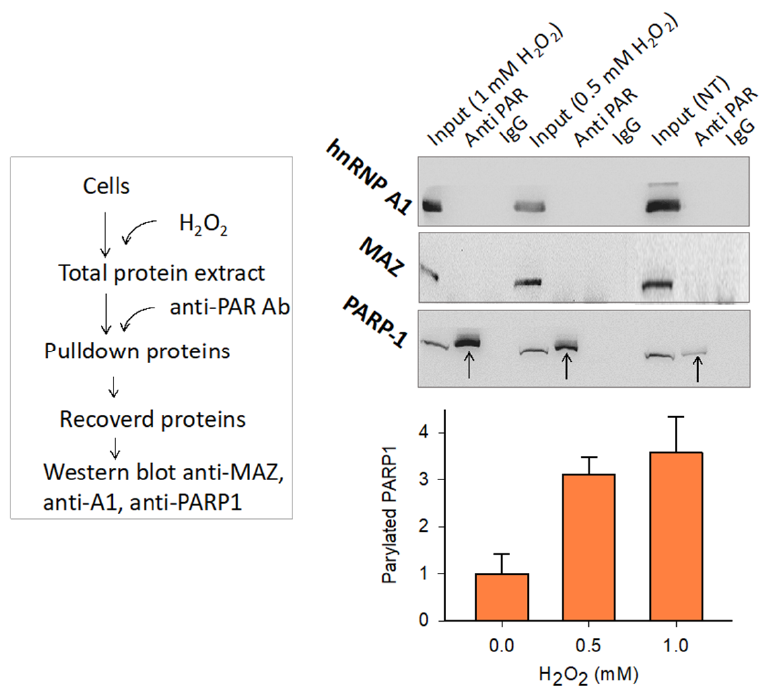
Figure 7. Anti-PAR immunoprecipitation assay. (Left) Experimental scheme; (Right) Western blot showing that among the PARylated proteins present in Panc-1 cells treated with 0.5 and 1 mM H 2 O 2 , there is only PARP-1 and not MAZ and hnRNP A1. The bar plot reports the ratio PARP-1 (pulled down) / PARP-1 (input) as a function of the H 2 concentration. Error bars are from two experiments.